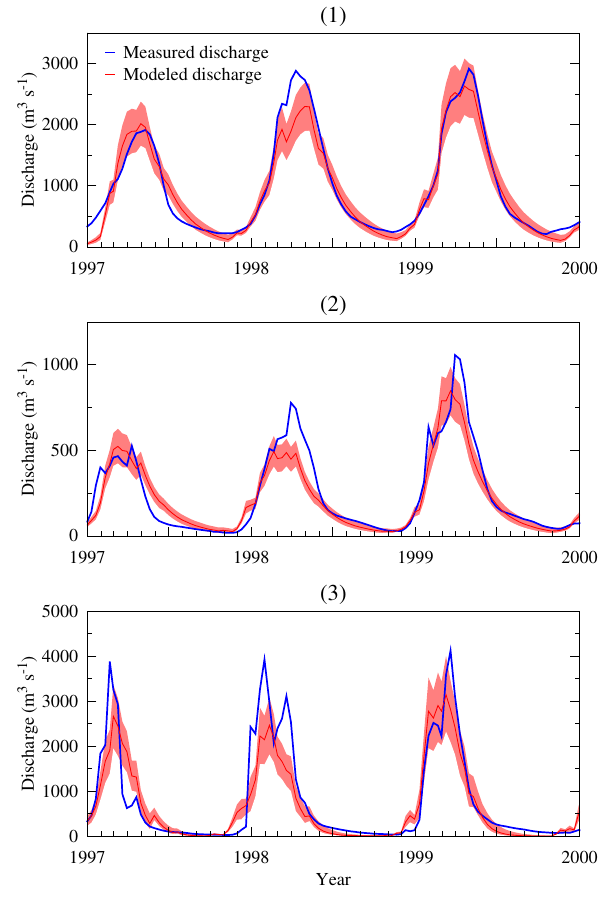
Fig. 5. The discharge simulated in the hindcast mode (red line) including the 95% confidence interval compared to the measured discharge (blue line) for the three watersheds Upper Zambezi (1) , Kafue River (2) and Luangwa River (3)